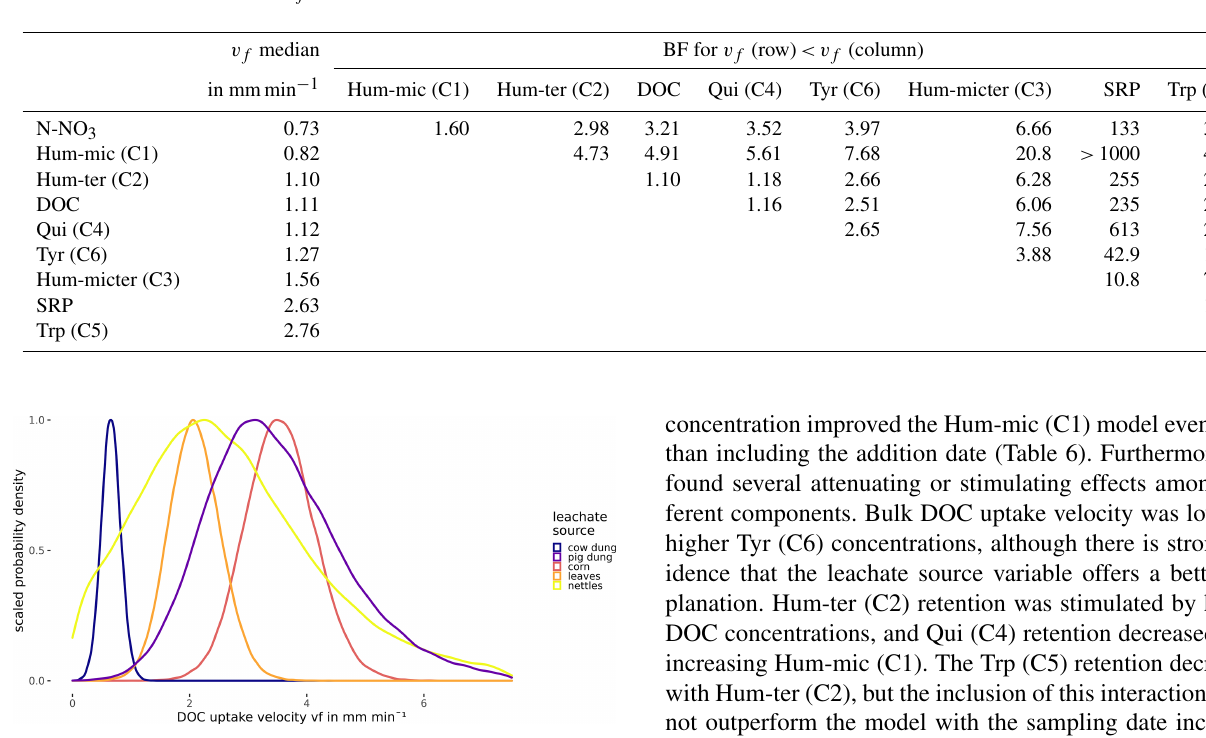
Table 5. Comparison of v f of DOM components and nutrients by the BF of one v f being lower than the other one. Additionally, the table presents median values of the v f distributions in millimetres per minute.